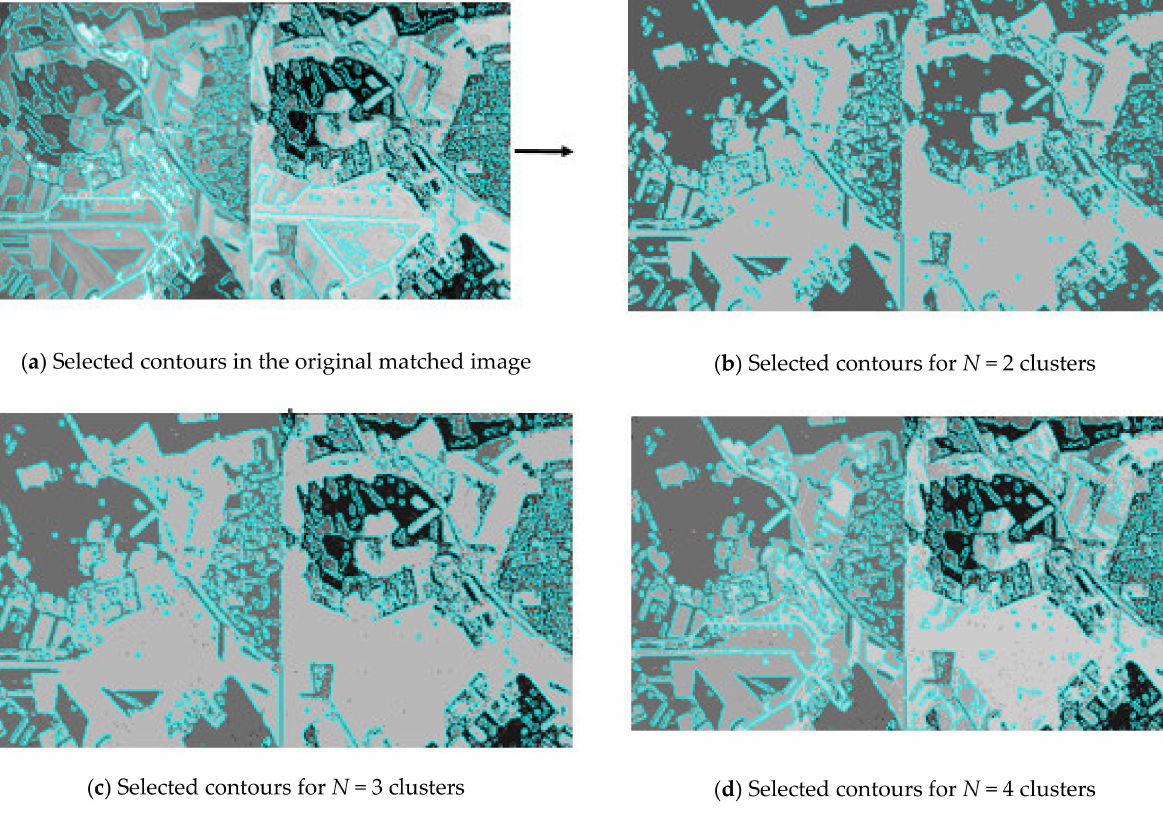
Figure 6. Boundary isolation by Canny edge detector on piecewise-constant